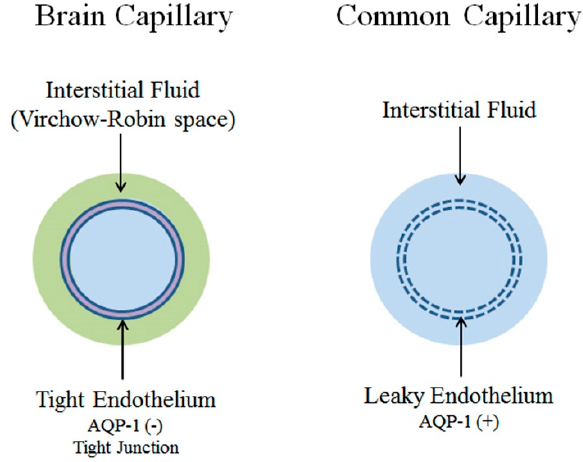
Figure 1. Capillaries. Common capillaries have a leaky endothelium due to the presence of fenestrations. The water channel aquaporin-1 (AQP-1) is also abundantly expressed. Accordingly, water dynamics between intracapillary and interstitial fluid space is directly connected (right). In contrast, brain capillaries lack fenestrations and have tight junctions. Expression of AQP-1 is actively suppressed. As a result, water dynamics in the intracapillary space and interstitial fluid space are effectively isolated from each other and must be analyzed independently. Modified from Reference [9].